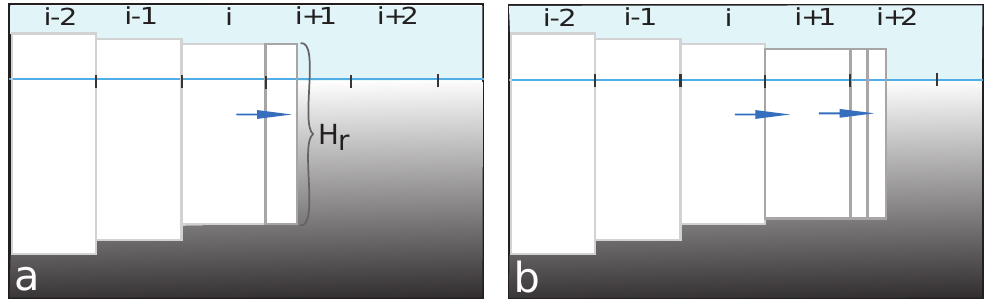
Fig. 2. Lateral view of discretized ice shelf with subgrid-scale parameterization. (a) The volume increment in grid cell [ i + 1 ] is associated with a slab of ice of the same ice thickness as the adjacent full shelf grid cell [ i ] . (b) When the grid cell [ i + 1 ] at the calving front is full of ice according to the associated reference thickness, the next following cell [ i + 2 ] can gain in ice volume.